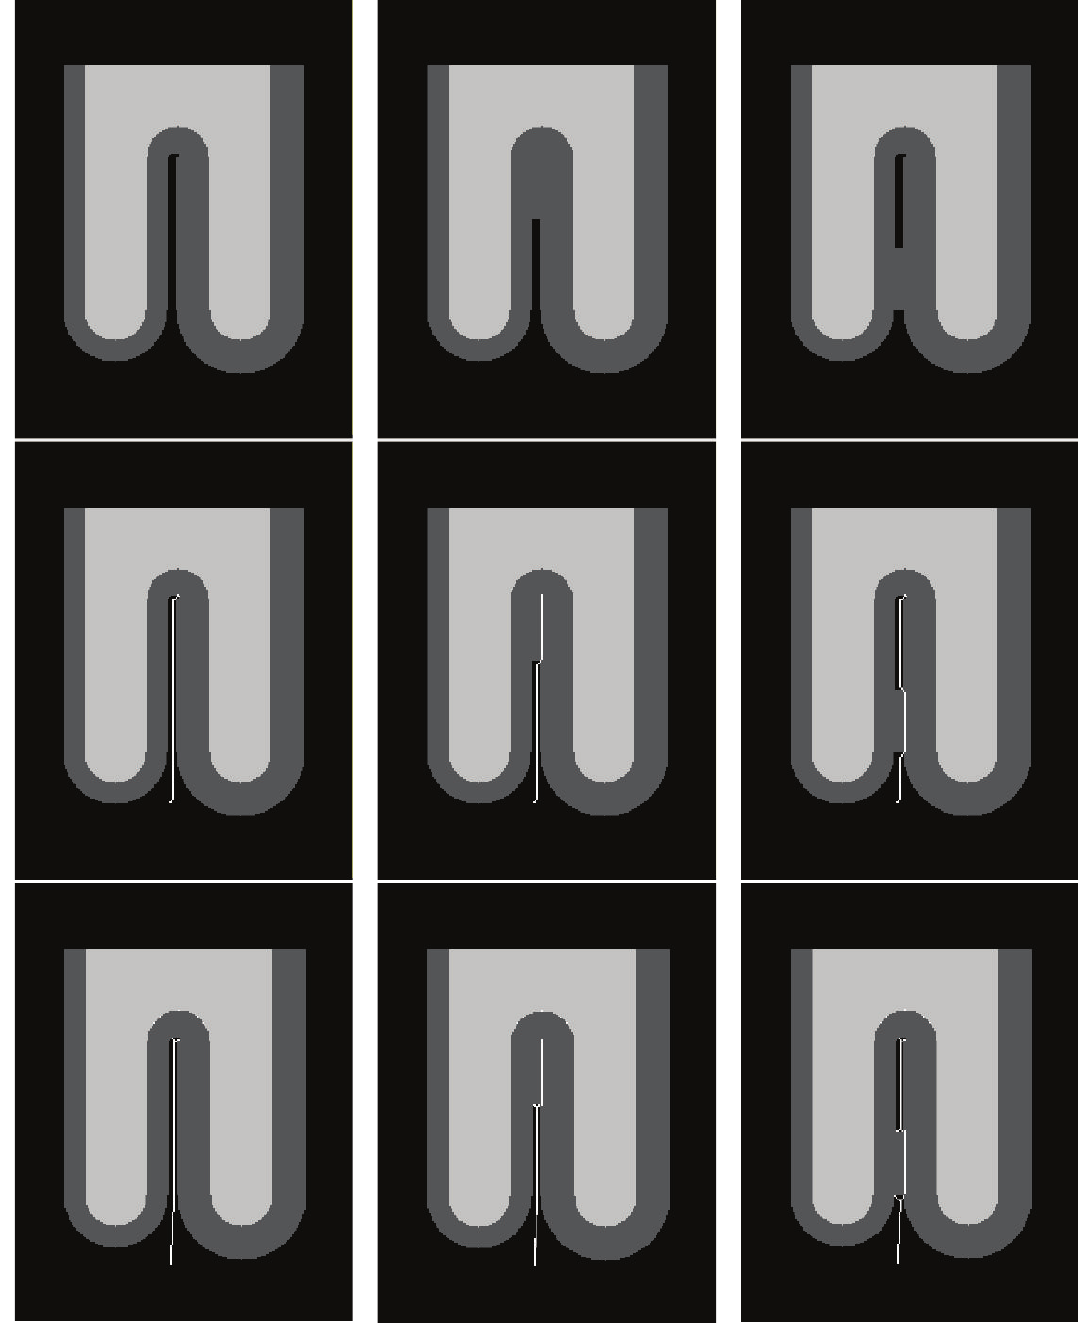
Figure 5: Cross-sections of simulated test images (left: fully resolved sulcus; middle: unresolved fundus; right: bridged sulcus). The white line shows the location of the identified sulcal medial surface skeleton. Comparison of DELFMAP (middle row) versus ACE (bottom row) shows that skeletons produced by DELFMAP have a more regular structure compared to ACE skeletons, which can have small extraneous branches and discontinuities. In the bottom row (ACE), small spurious components are visible at the fundus very close to WM, which in ACE method have to be suppressed by thresholding the distance from